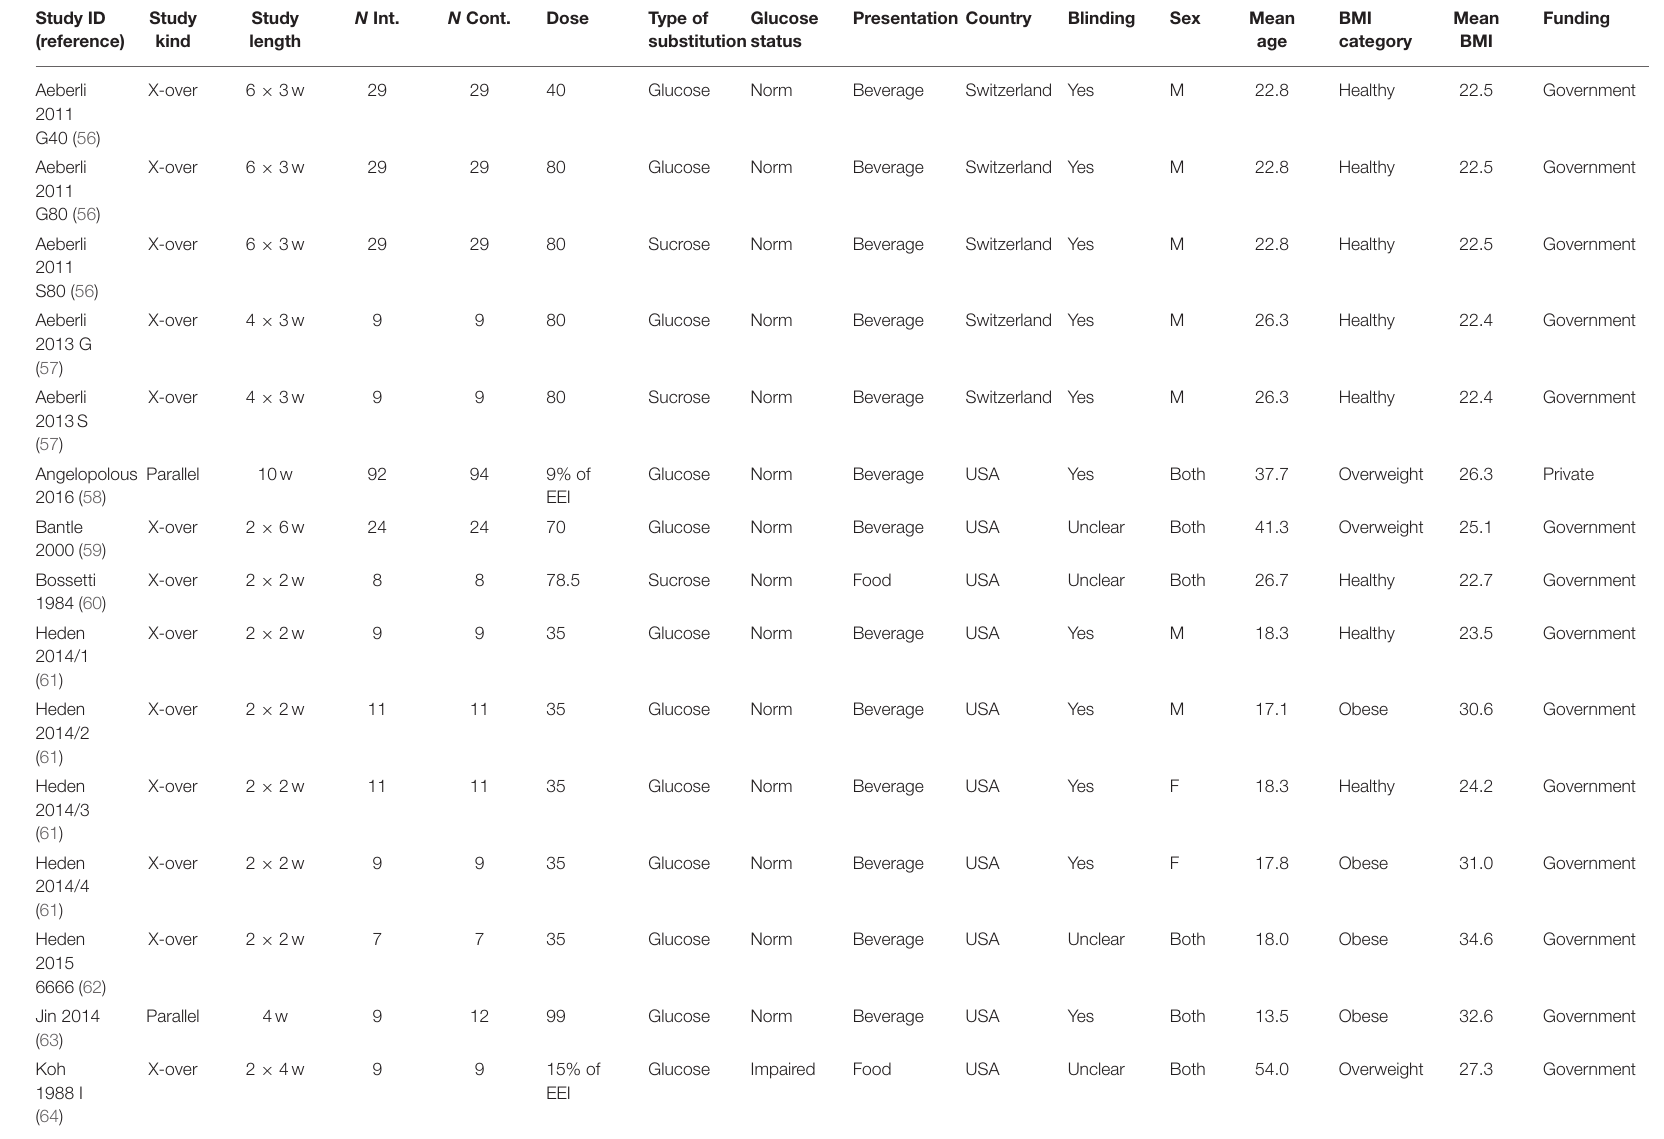
TABLE 1 | Characteristics of included